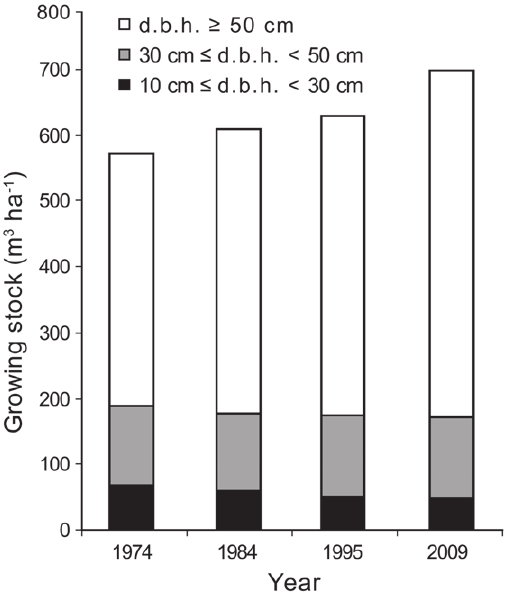
Figure 8. Distribution of growing stock in three d.b.h. classes in the Gorjanci forest reserve. ‘‘d.b.h.’’ is diameter at breast height.